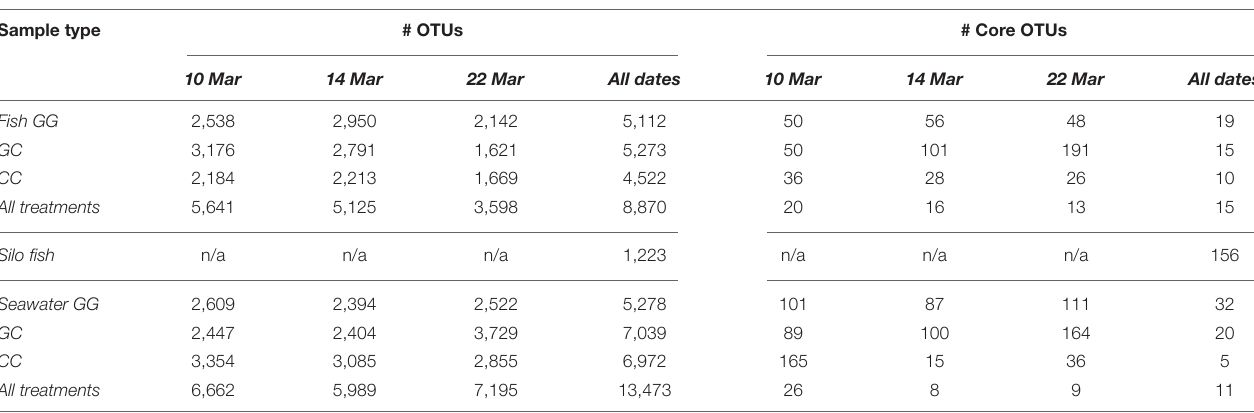
FIGURE 4 | Venn diagrams showing the number of shared OTUs on the final sampling date (22 Mar) among fish and seawater samples. (A) OTUs from fish microbiomes of each treatment and (B) seawater microbiomes. TABLE 2 | OTU counts from all samples by sample types and